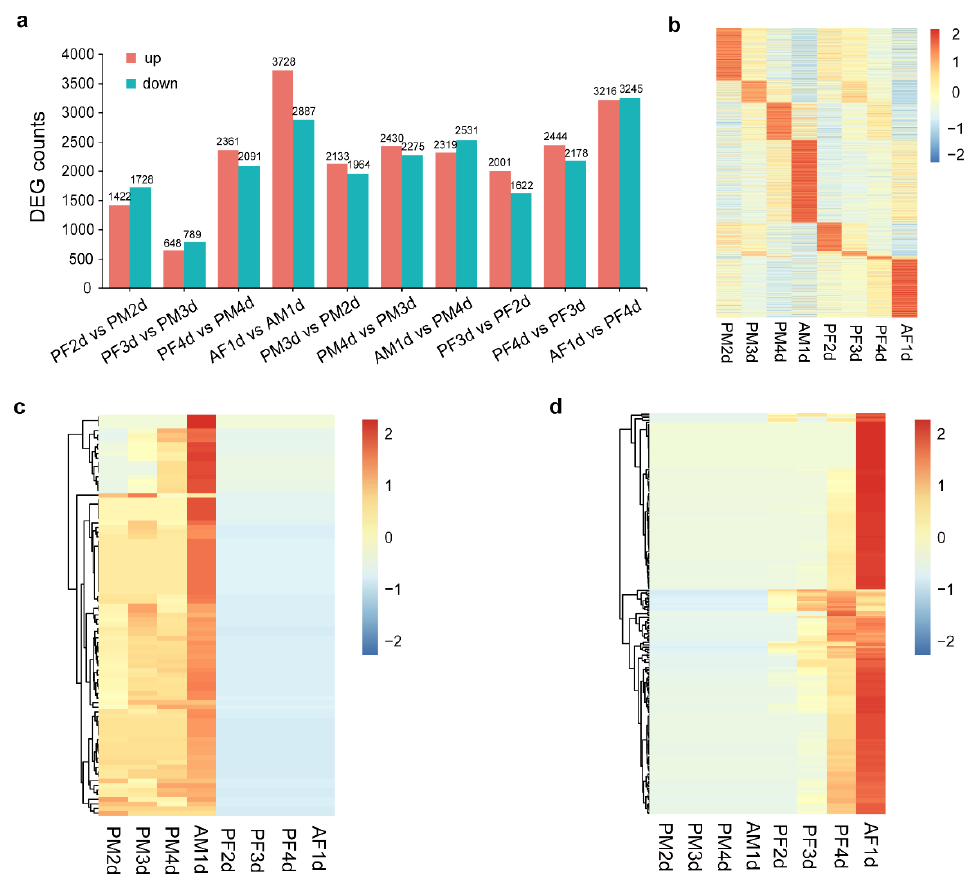
Figure 3. Analysis of differentially expressed genes (DEGs) between male and female wasps of pharate adult and adult development of C. vestalis. ( a ) Numbers of DEGs between of pharate adult and adult development of C. vestalis. Red bars represent up-regulated genes, and blue bars represent down-regulated genes. ( b ) Stage-specific expression of genes in C. vestalis. Red and blue colors in the heat map indicate high and low expression levels, respectively. ( c ) Male-specific genes in all developmental stages. ( d ) Female-specific genes in all development stages.